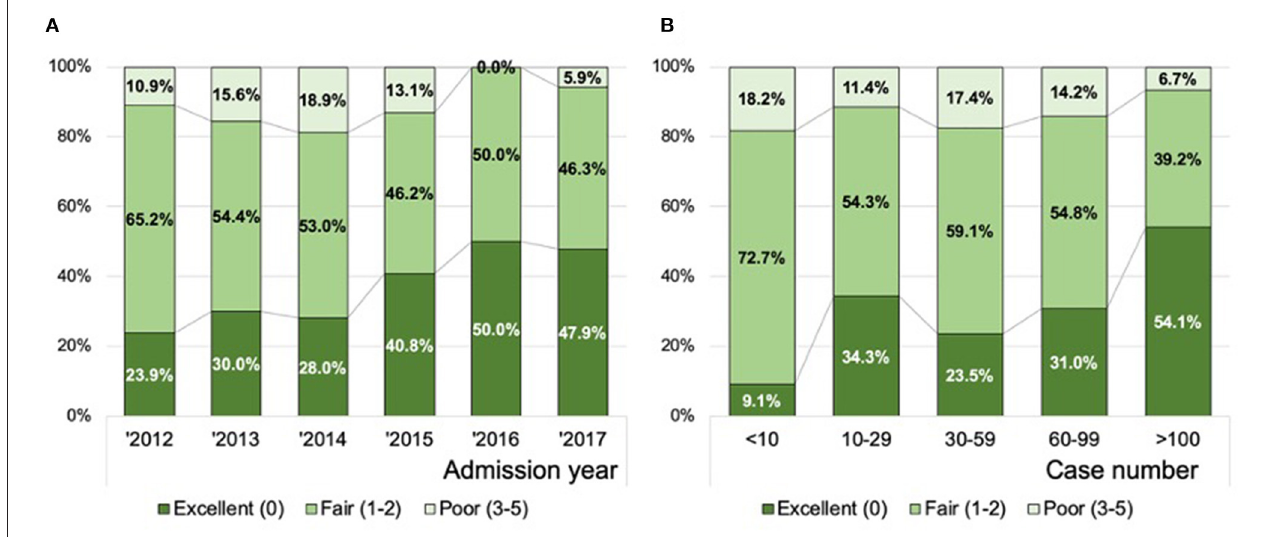
FIGURE 2 | Distribution of the successful recanalization score according to the year of admission (A) and the volume of thrombectomy cases at each site (B) . Data in combined training and all validation populations are presented ( n = 602).